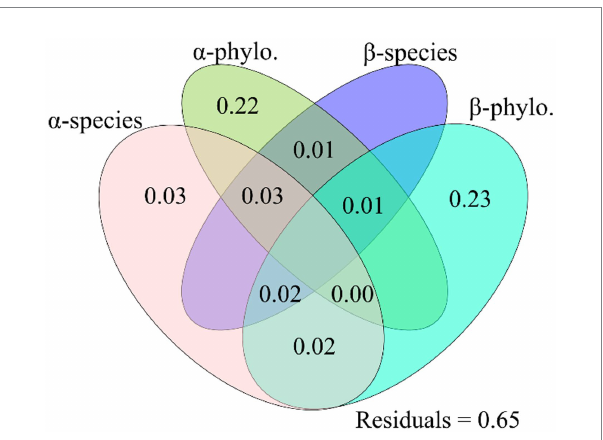
FIGURE 4 The excluded and interactive impacts of the dissimilarity of α -species and α -phylo., β -species and β -phylo. on the dissimilarity of plant community aboveground net primary production between C4313 versus W4513, C4313 versus W4693, and C4513 versus W4693. The α -phylo. and α -species indicated phylogenetic and species α -diversity, and β -phylo,. and β -species indicated phylogenetic and species β -diversity between C4313 versus W4513, C4313 versus W4693, and C4513 versus W4693, respectively. C4313: non- warming plots at elevation 4,313 m; C4513: non-warming plots at elevation 4,513 m; W4513: warming plots at elevation 4,513 m; W4693: warming plots at elevation 4,693 m. Species and phylogenetic β -diversity data were obtained from Wang et al. (2021a,b), Frontiers in Ecology and Evolution.